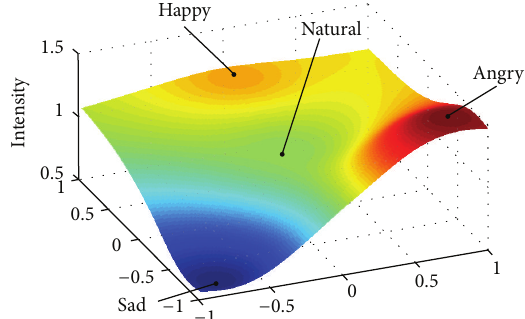
Figure 7: Map between the 𝑥 - 𝑦 coordinates in the control space and the Intensity feature.